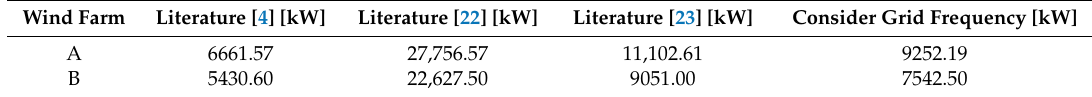
Table 2. The selection of the threshold value of two wind